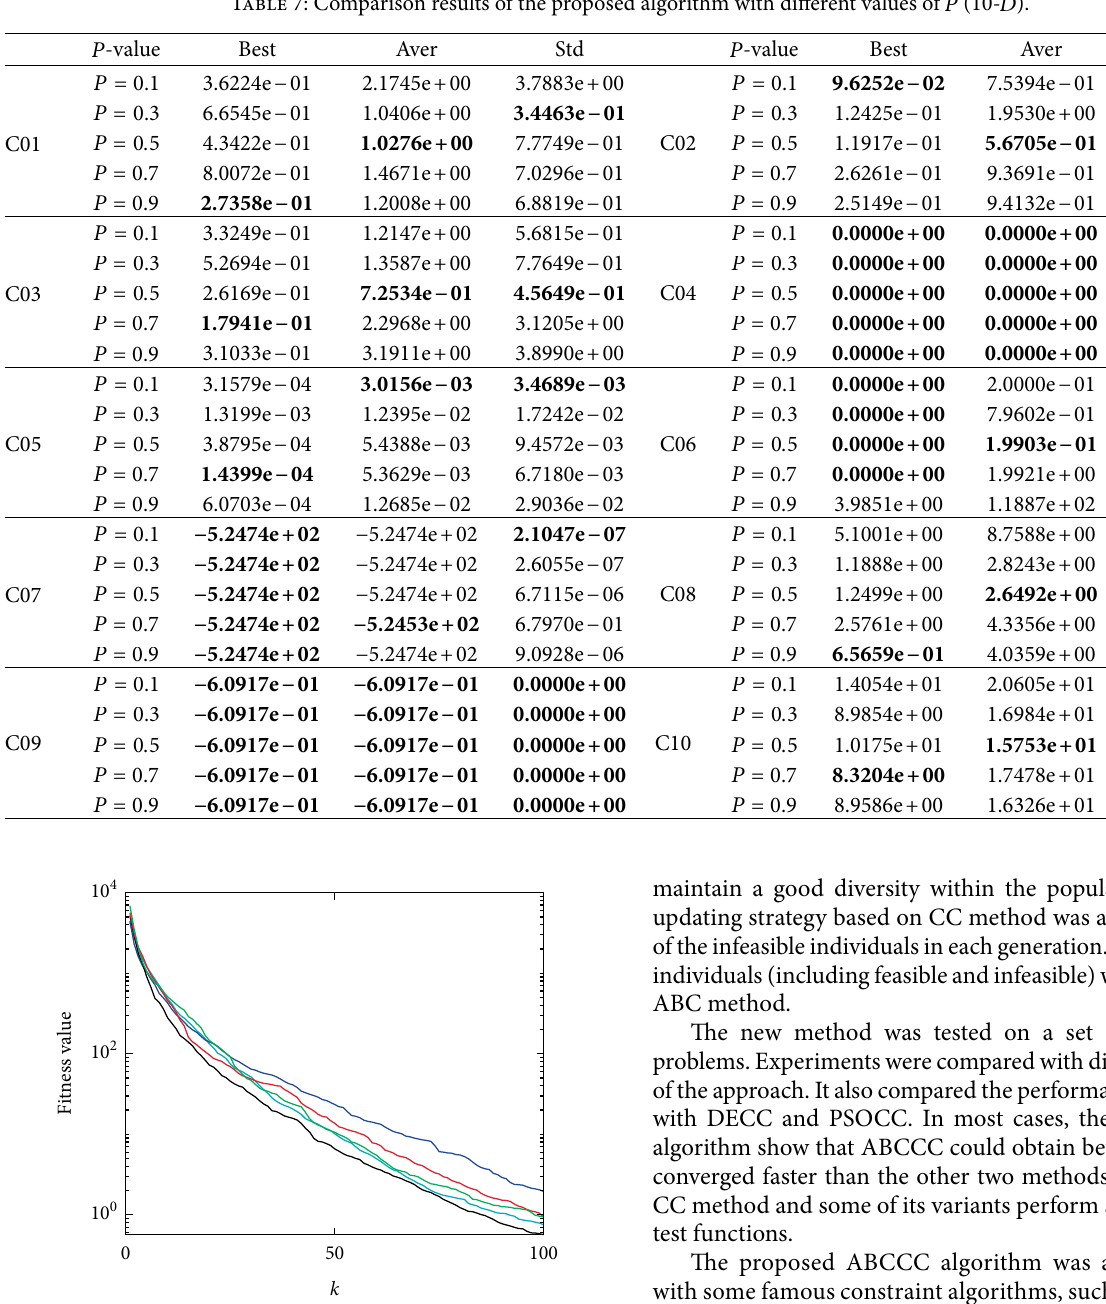
Table 7: Comparison results of the proposed algorithm with different values of